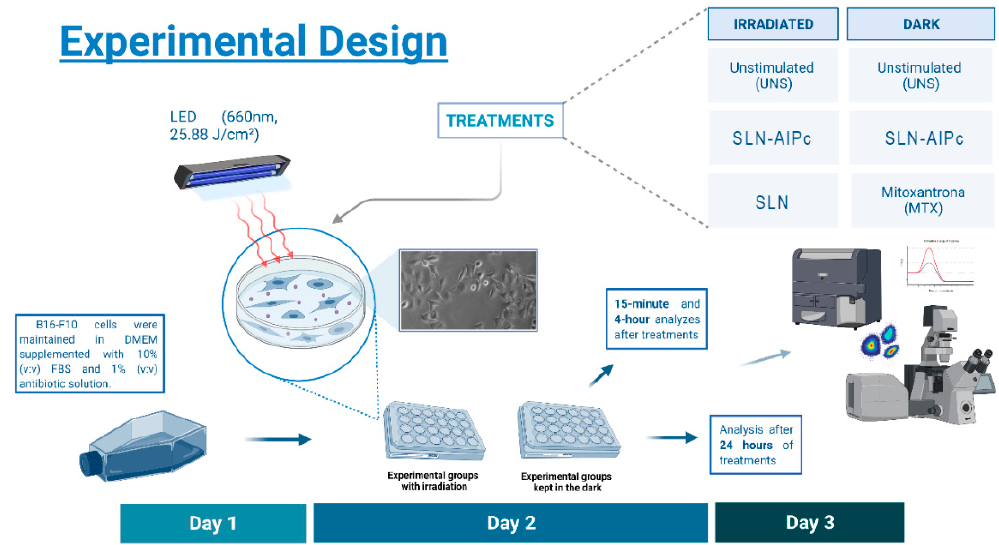
Figure 1. Experimental design for the in vitro analyses. Day 1: B16-F10 cells were cultivated for 24 h. Day 2: B16-F10 cells were washed in PBS and then treated with PDT. In the SLN-AlPc treatment, B16-F10 were treated and then irradiated for 10 min (660 m, 25.88 J/cm 2 ). Day 3: Different analyses were carried out 24 h after the treatment.